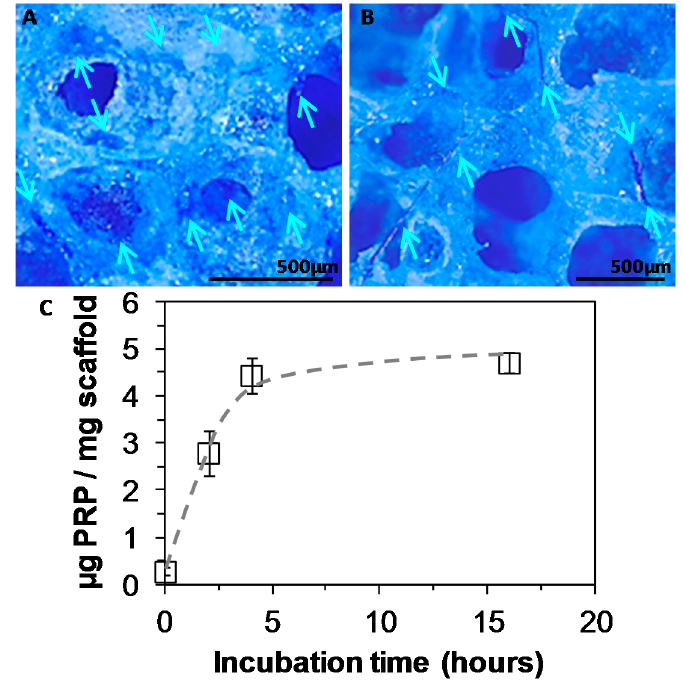
Figure 6. A , B : Staining of platelet rich plasma (PRP) adsorbed into PEUUF sca ff olds due to complexation with Coomassie blue (PRP concentration used for bio-activation = 15 vol% (16 h of incubation)) (Arrows indicate some locations of PRP in images). C : Amount of PRP adsorbed into PEUUF sca ff olds as a function of incubation time in a 15 vol% PRP solution (The LMW fucoidan concentration in the aqueous phase of the HIPE used for functionalization = 10 mg mL − 1 ).